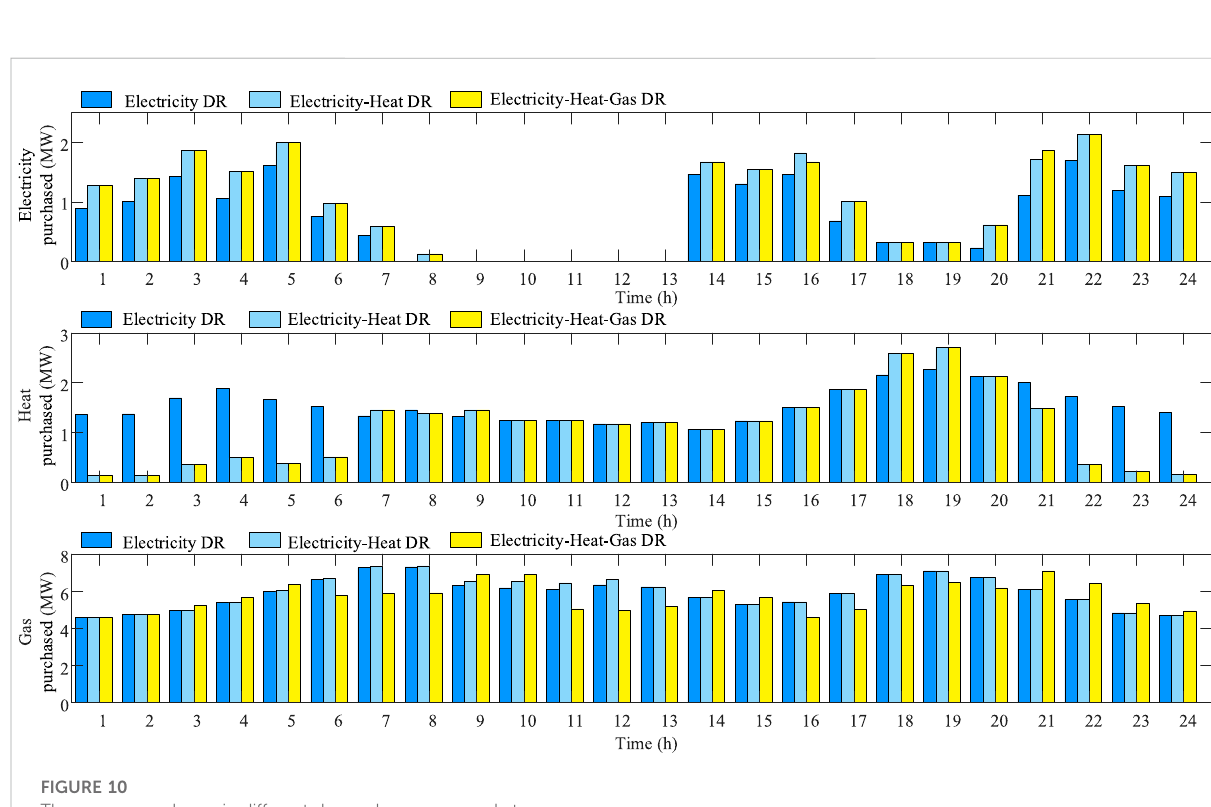
FIGURE 10 The energy purchases in different demand response